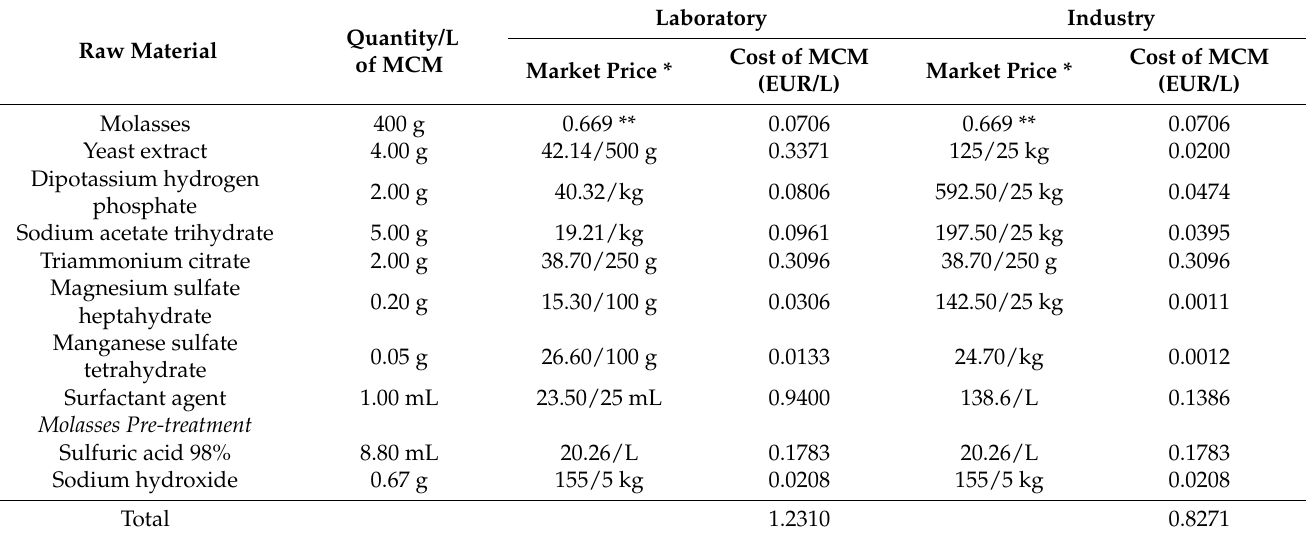
Table 5. Cost of preparing molasses culture medium (MCM) for Laboratory and